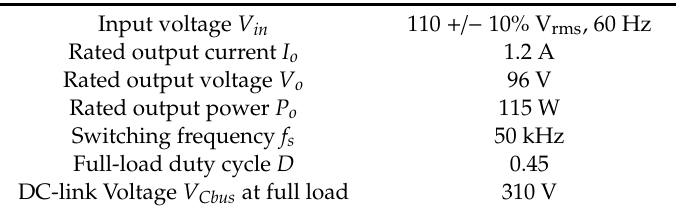
Table 1. Circuit Specification.